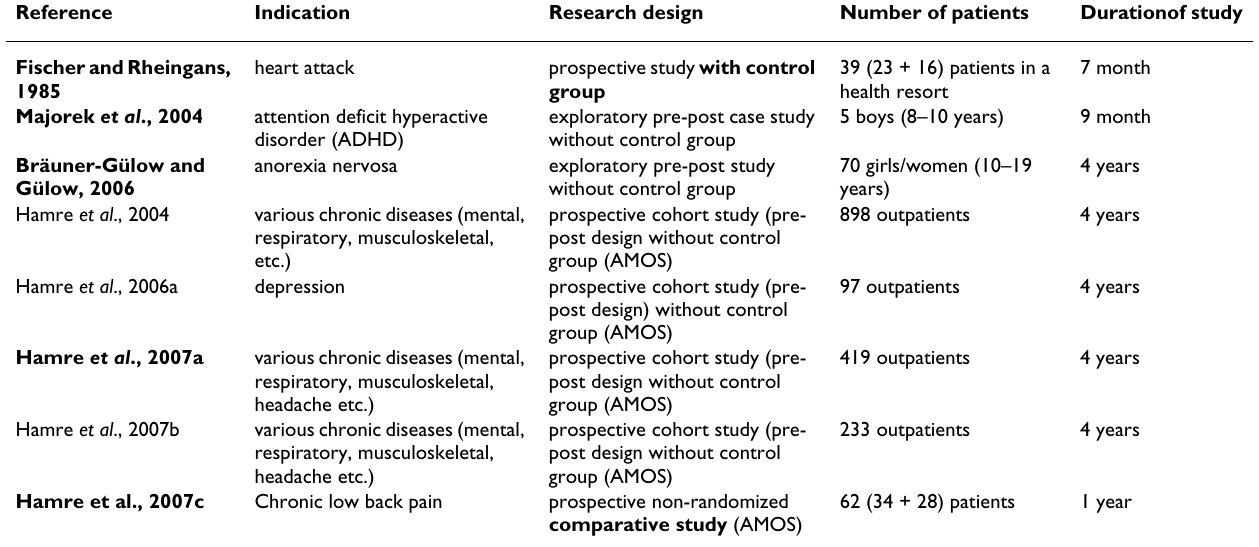
Table 2: Design of clinical studies enrolling therapeutic eurythmy (with and without add-on treatments)